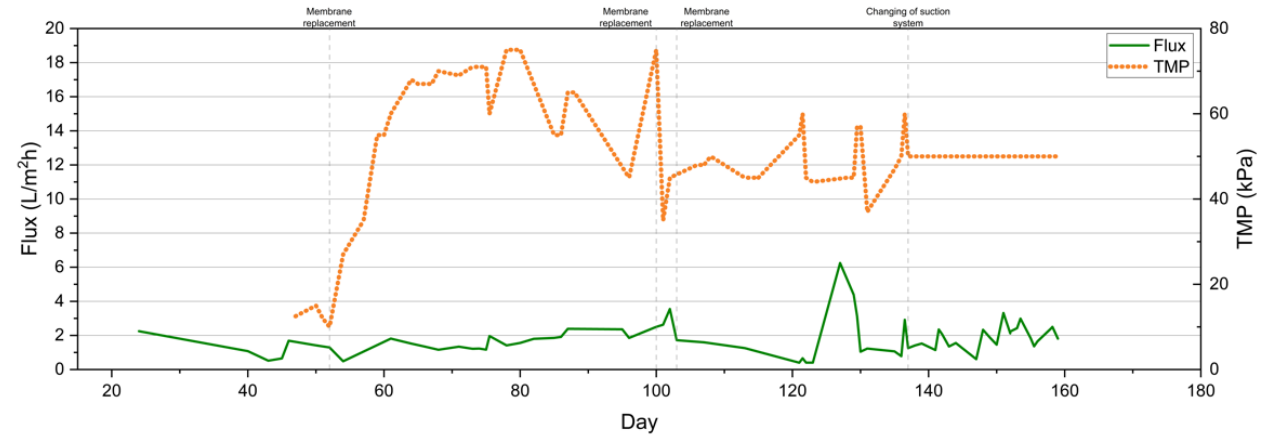
Figure 3. Temporal variation of flux and transmembrane pressure (TMP).